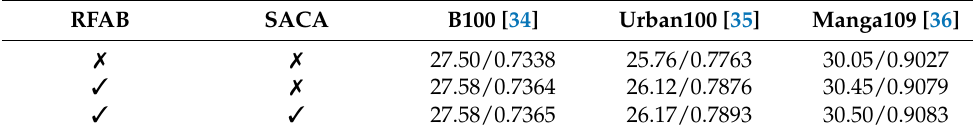
Table 1. Investigation of RFAB and SACA with scaling factor × 4.